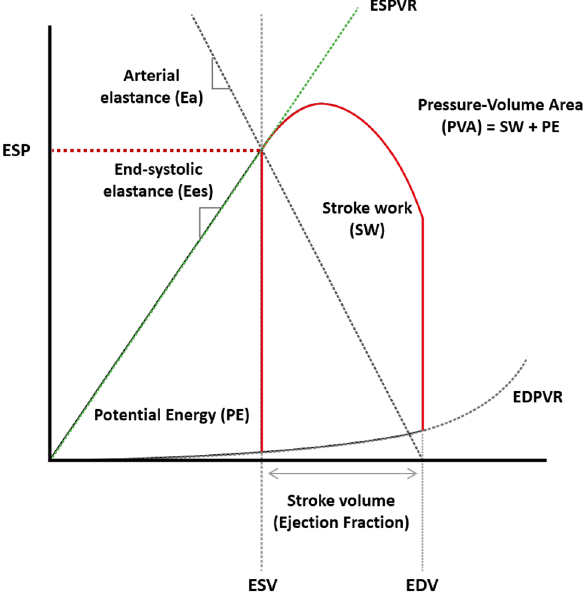
Figure 2. Schematic view of a pressure–volume loop. EDPVR end-diastolic pressure–volume relationship, ESPVR end-systolic pressure–volume relationship, ESP end-systolic pressure, PVA pressure–volume area, EDV end-diastolic volume, ESV end-systolic